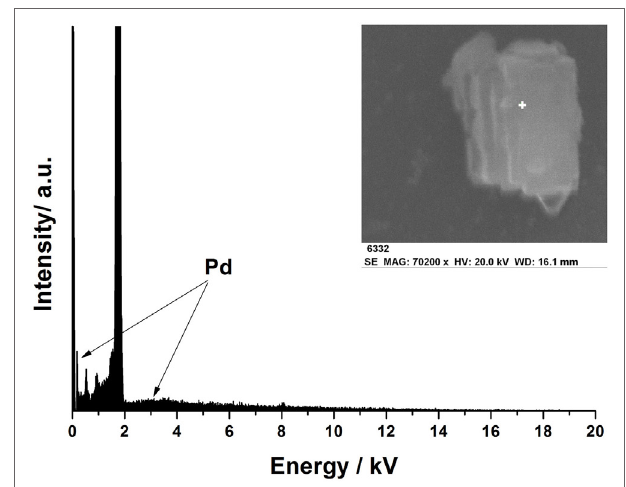
FIGURe 2 | Energy dispersive spectrometer result on the surface of Pd-zeolite Y after H 2 treatment under 200°C (inset: scanning electron microscopy image of Pd-zeolite